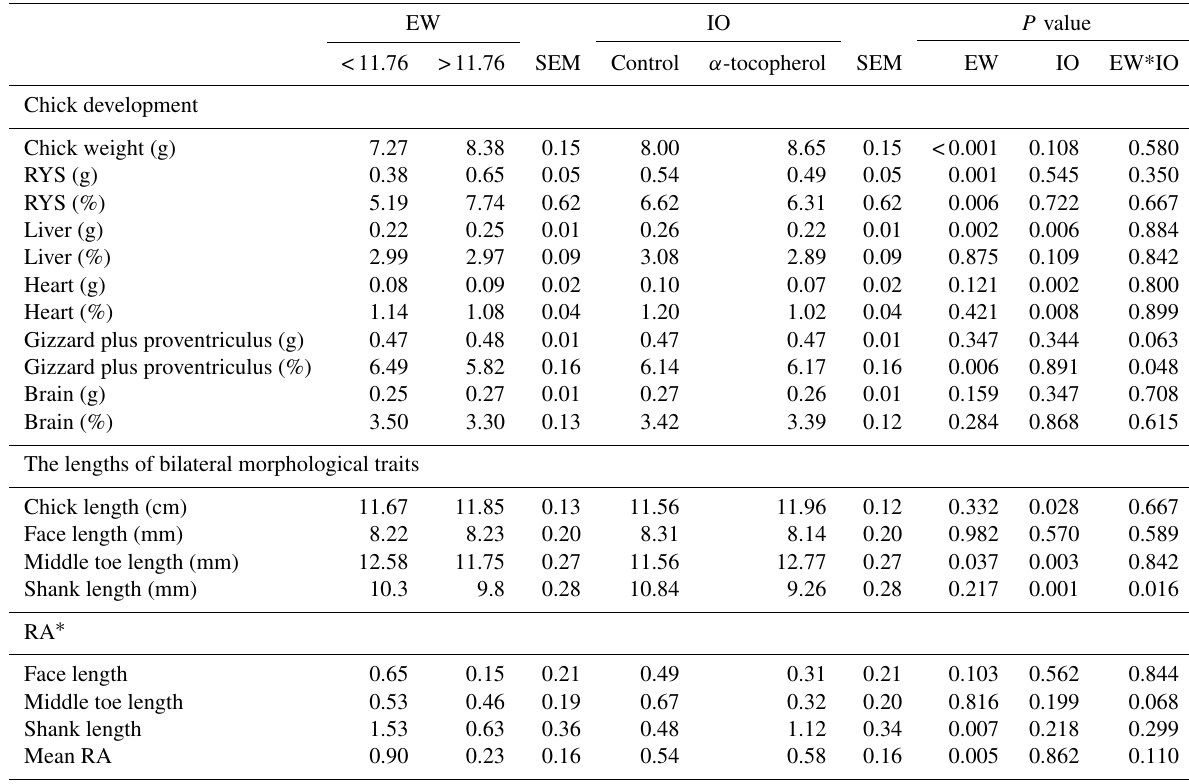
Table 3. The effects of egg weight and in ovo administration of α -tocopherol on weights of the chick, residual yolk sac, liver, heart, gizzard plus proventriculus, and brain during development and on morphological traits, relative asymmetry and mean relative asymmetry of bilateral traits in the quail